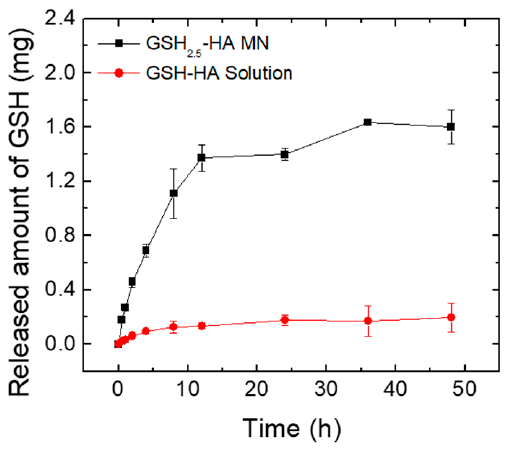
Figure 6. In vitro release profiles of GSH from GSH 2.5 -HA MN patches and GSH 2.5 -HA solution analyzed by the Franz cell assay.